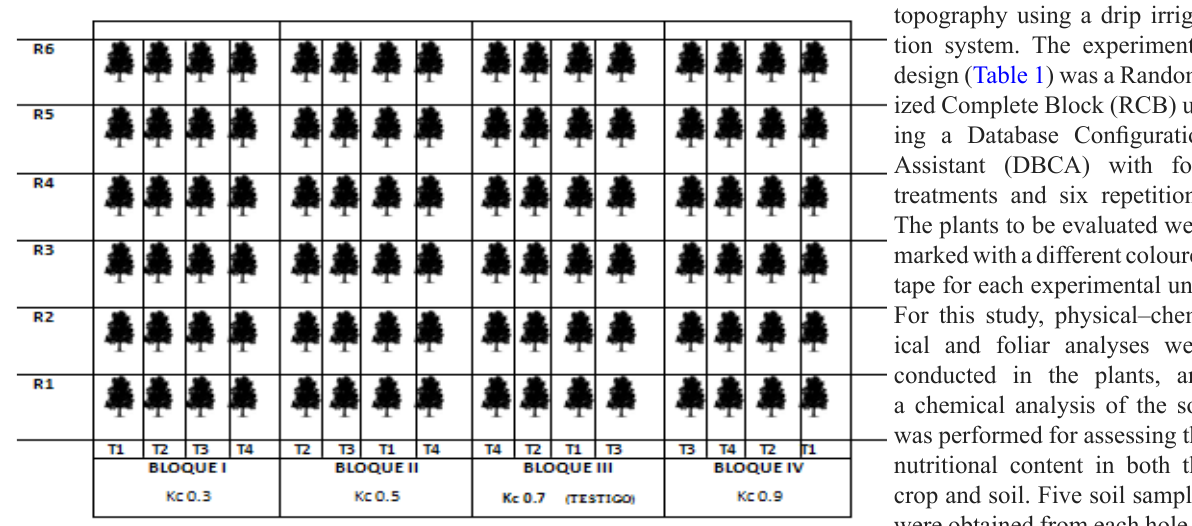
Table 1. Field experimental design.